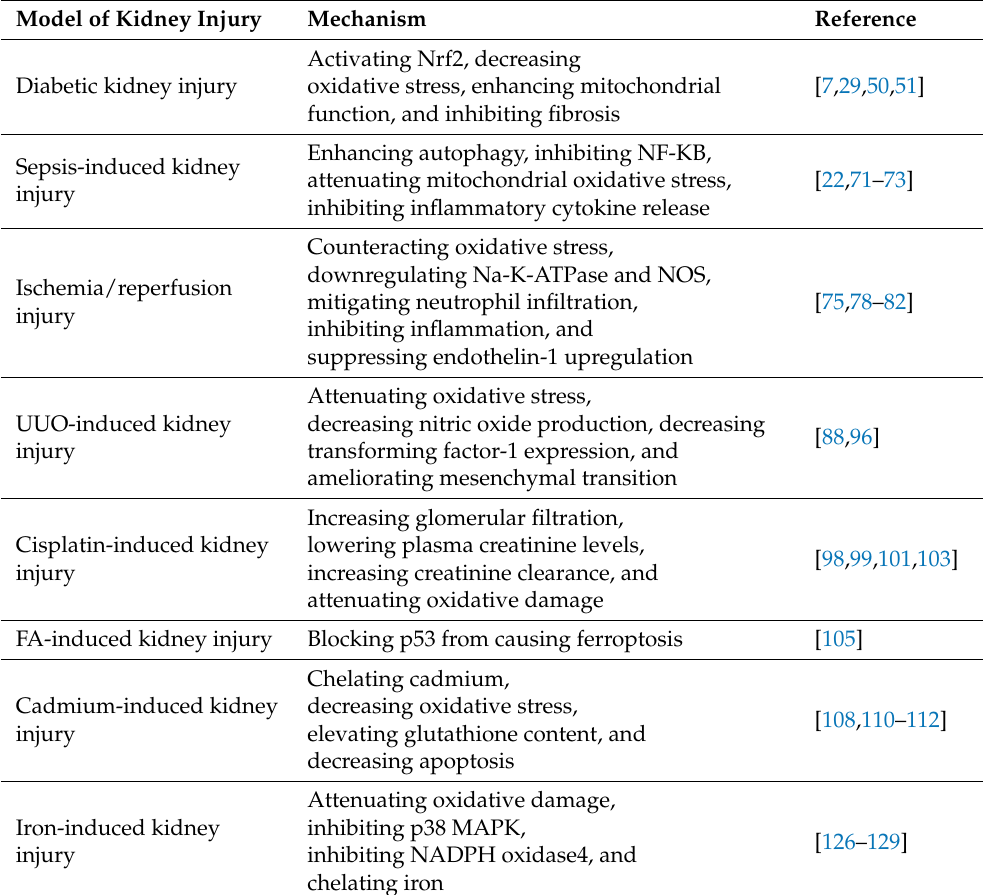
Table 1. Mechanisms of ALA’s renal protection in various animal models of kidney injury discussed in this